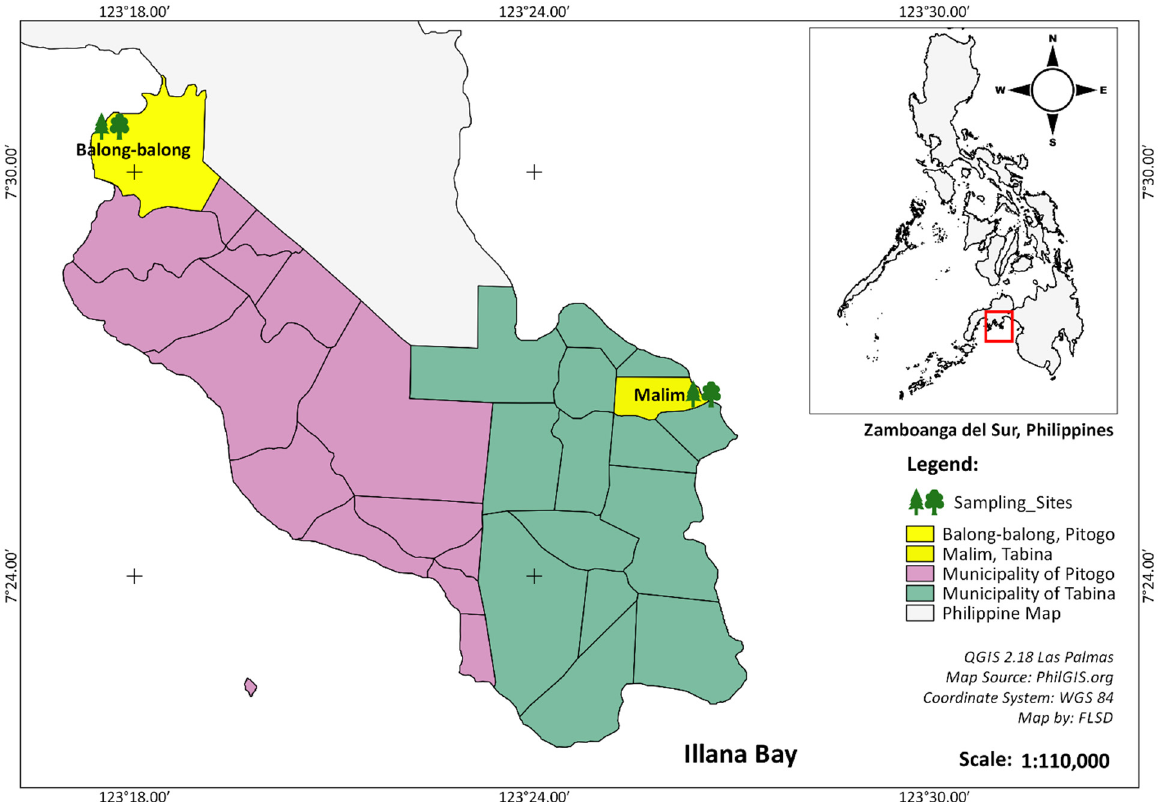
Figure 1. Location map of natural and reforestation stands in Zamboanga del Sur, Philippines.